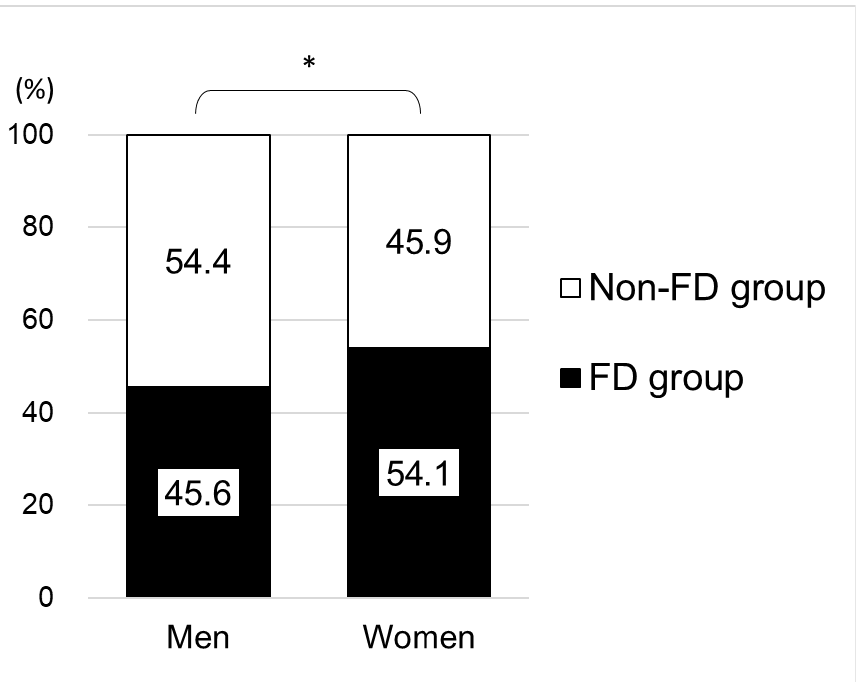
Figure 1. Proportion of the FD group by gender (total number: 3556; 1708 men, 1848 women). Note: Combined men and women: of 3556 participants, 1778 were in the FD group (50.0%); FD group = a group of those who regularly manage their oral health by having a family dentist, chi-squared test; * p <